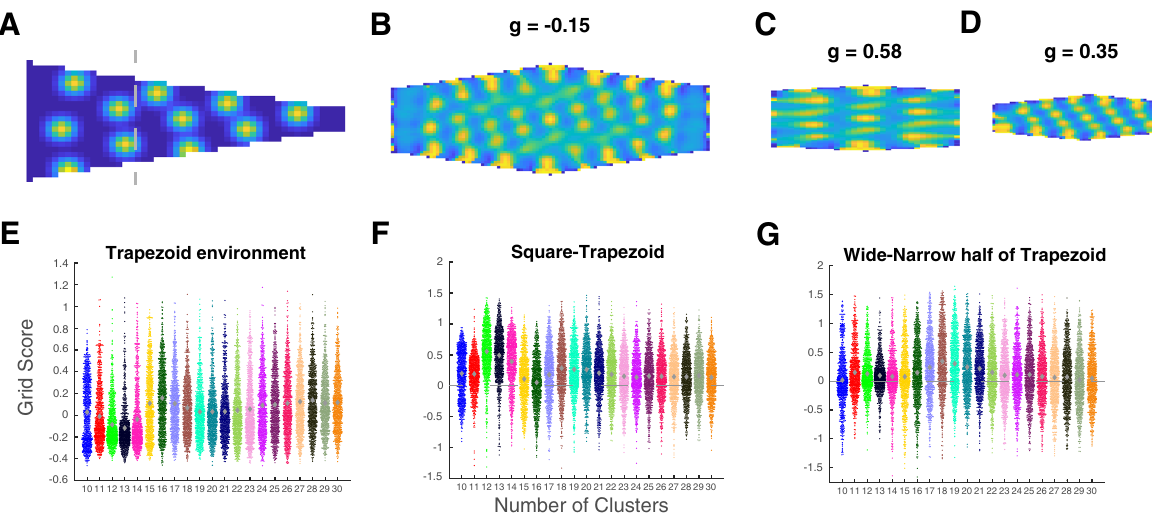
Fig. 4 The clustering model captures declines in grid responses in trapezoid environments. a – d Example of distortion in a trapezoid environment. a Example of an activity map in a trapezoid environment with 18 clusters. The dotted line demarcates the wide and narrow halves of the trapezoid. b Spatial autocorrelogram of the trapezoid. c Spatial autocorrelograms of the wide (left) and d narrow (right) portion of the trapezoid in a . e Univariate scatterplot showing grid scores for simulations in the trapezoid enclosure after learning in a square enclosure. f The difference (positive) between grid scores in the square and trapezoid. g The difference (positive) between grid scores for the wide and narrow halves of the